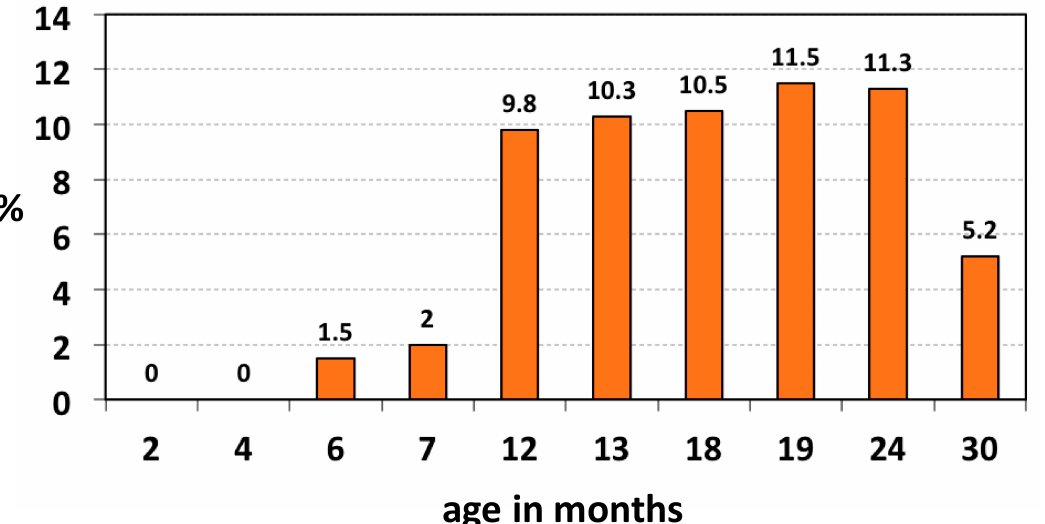
Figure 3. Age-related prevalence of oropharyngeal K. kingae colonization.